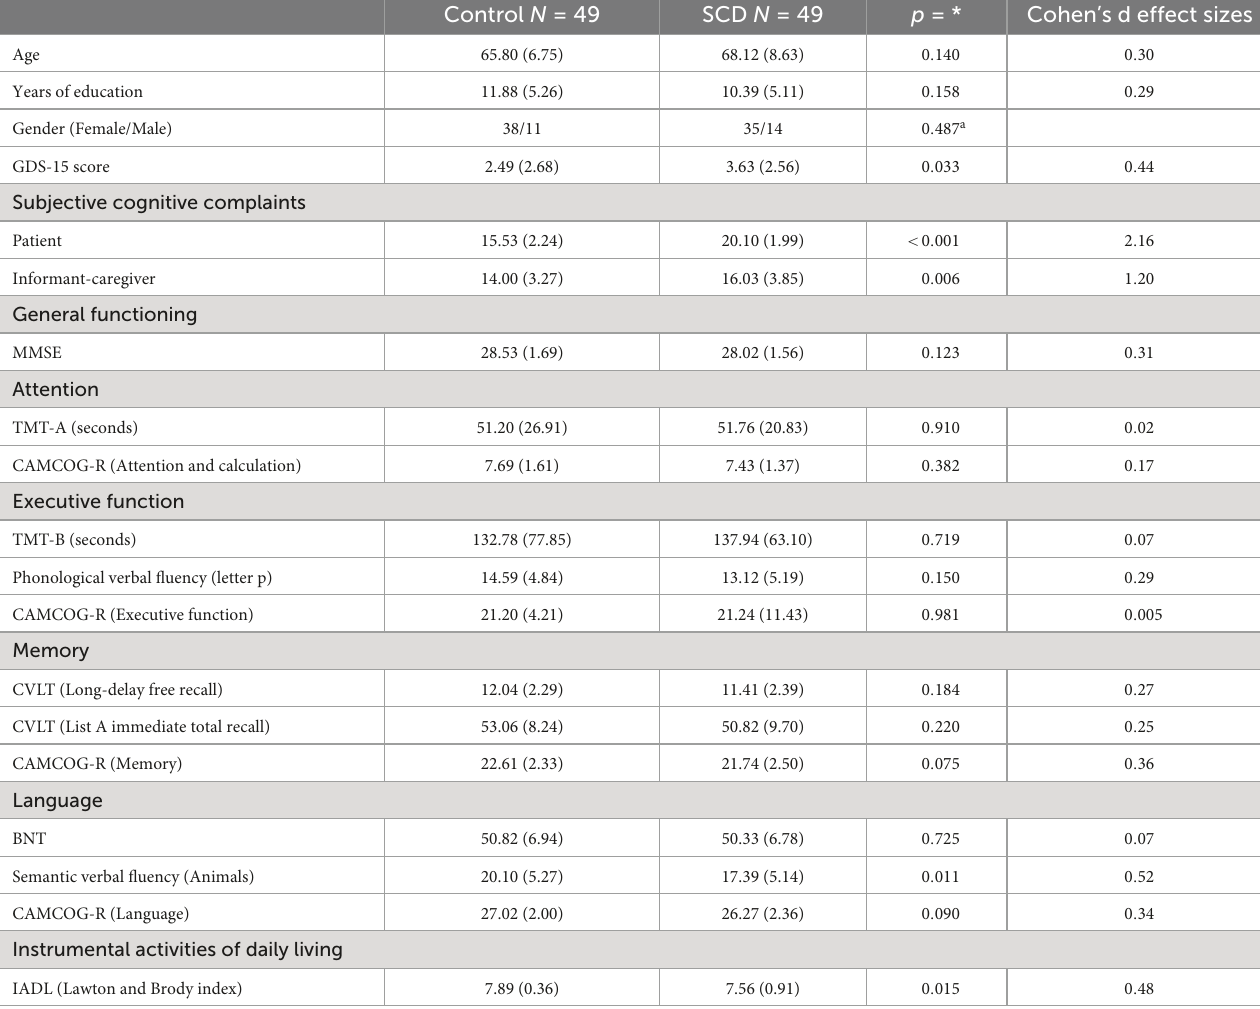
TABLE 1 Mean values and standard deviations (SD, in brackets) of demographic and neuropsychological measures in the control (cognitively unimpaired individuals) and the subjective cognitive decline (SCD)